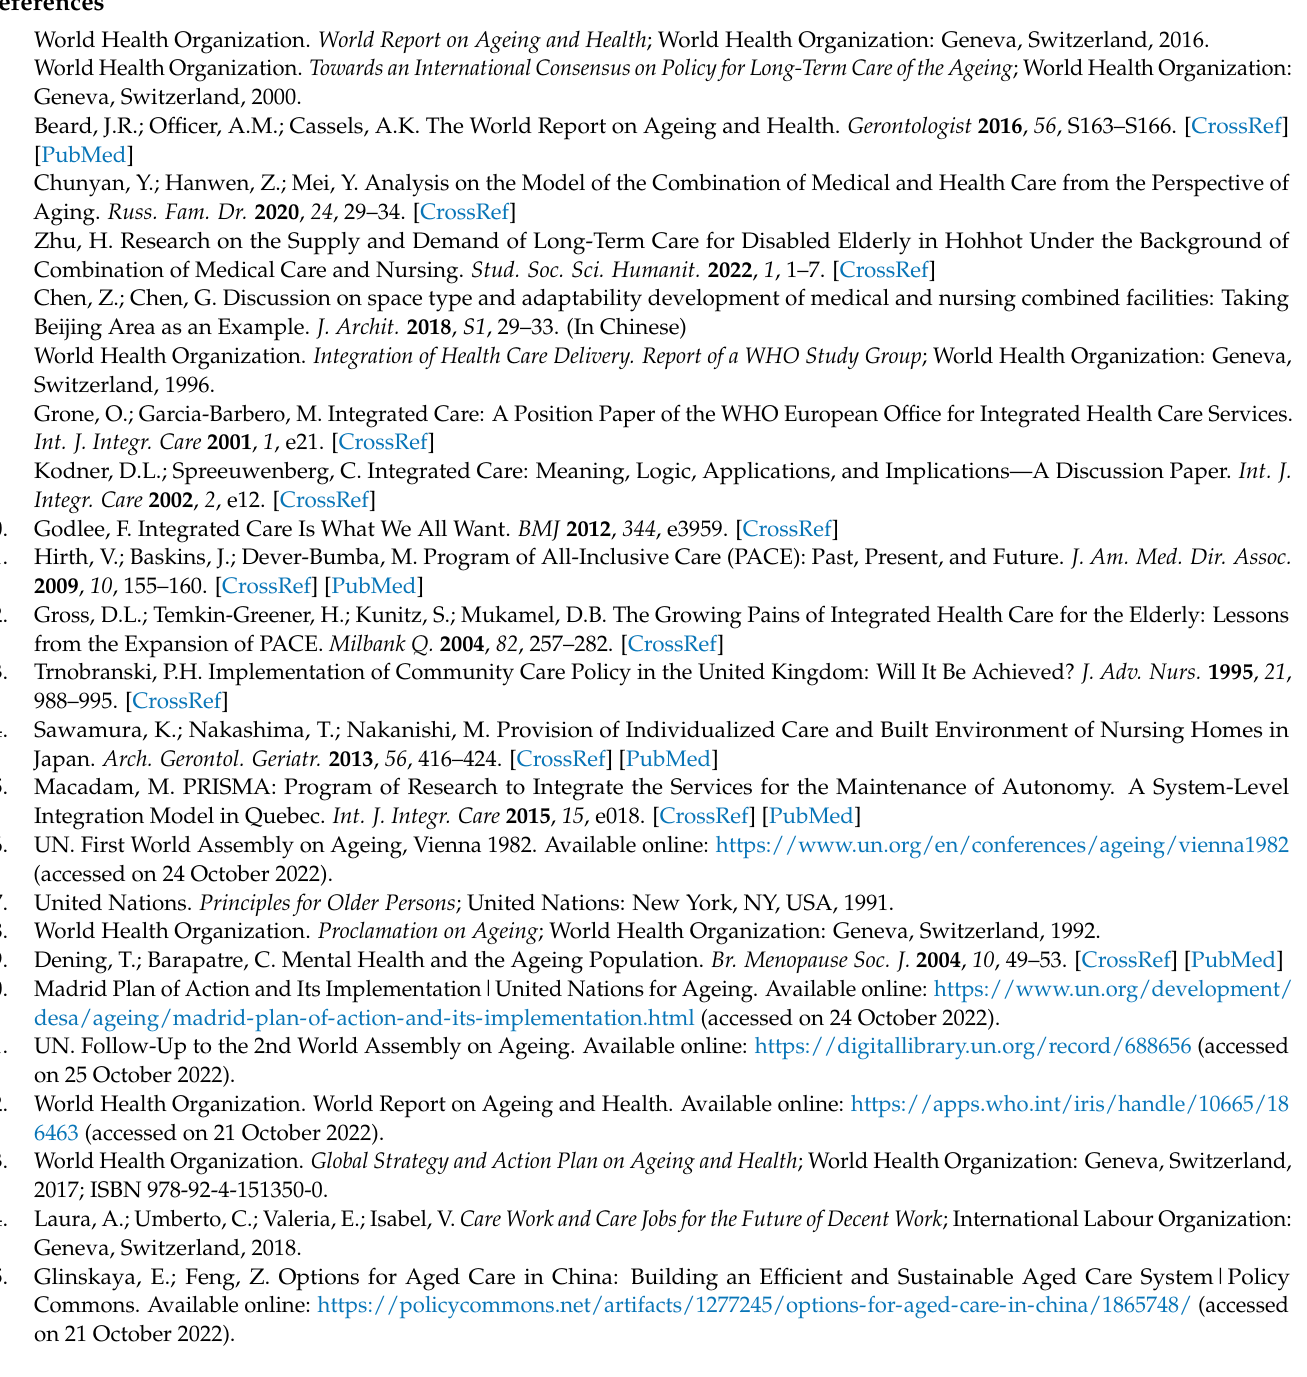
Table A1. Bibliometric analysis softwares used to produce Figures 7–12. Figure 7 Generated using Citespace software Figure 8 Generated using Citespace software Figure 9 Generated using VOSviewer software Figure 10 Generated using VOSviewer software Figure 11 Generated using Citespace software Figure 12 Generated using Citespace